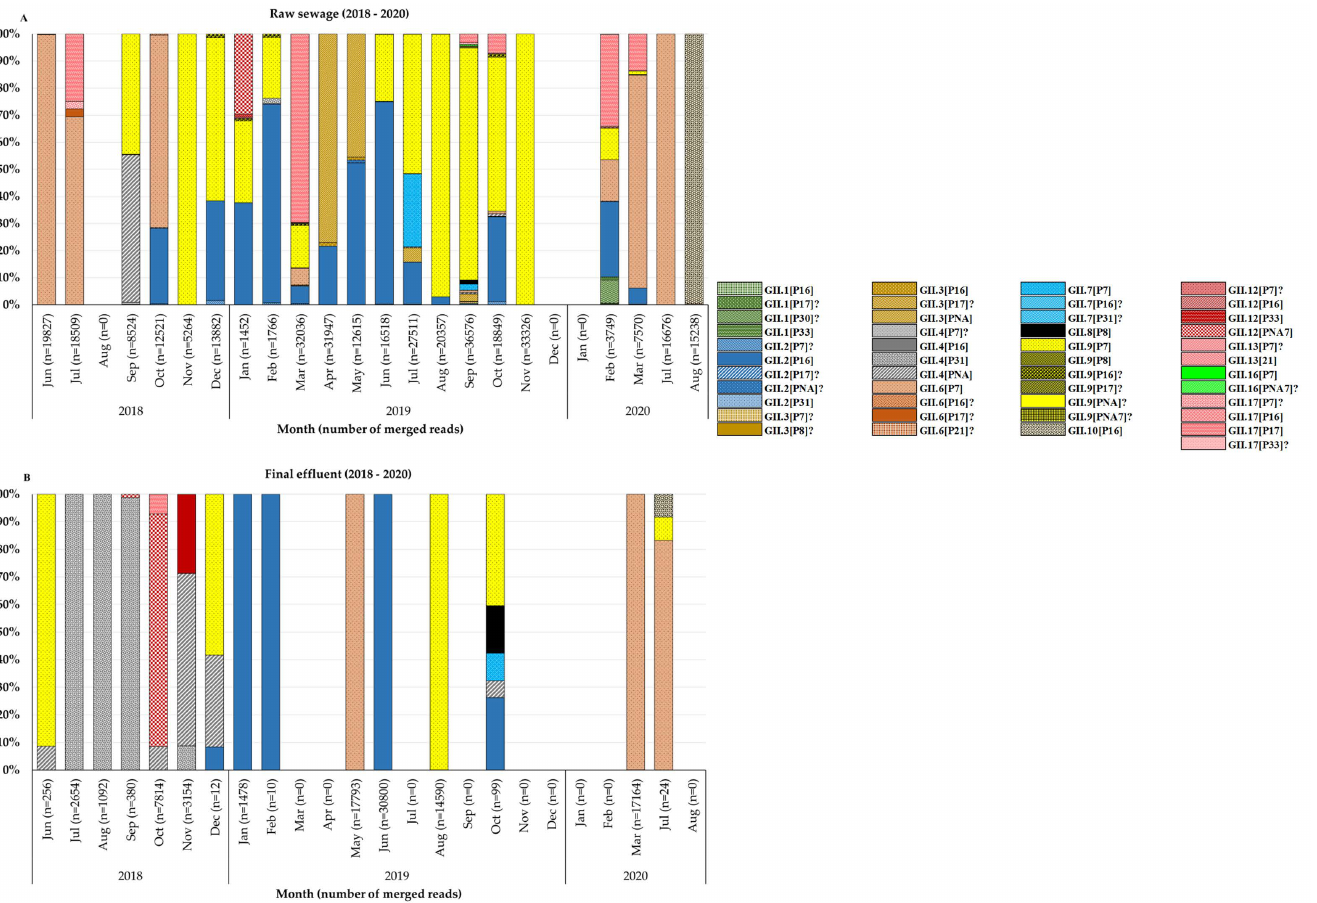
Figure 3. Norovirus GII molecular typing. Distribution and abundance of norovirus GII strains identified from ( A ) raw sewage and final effluent ( B ) samples between June 2018 and August 2020. The amplicons from different sampling sites were pooled equimolar based on wastewater sample type and month of collection. The numbers in parentheses indicate the number of merged reads for each month. The key shows known RdRp-capsid combinations and putative novel recombinants